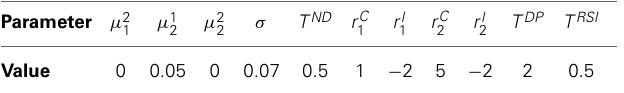
Table 4 | Task parameters used in the third example.